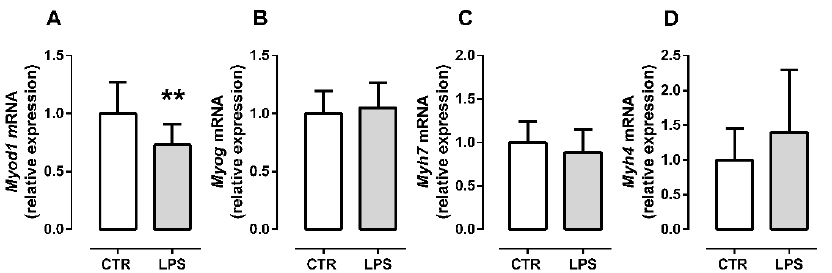
Figure 2. LPS administration affects initial myogenic stimulus but not late differentiation. Myod1 expression at 24 h post differentiation induction ( A ) and expression of Myog ( B ), Myh7 ( C ), and Myh4 ( D ) in C2C12 myocytes/myotubes mixed culture at 96 h post differentiation induction. The white bar represents the control group (CTR), and the gray bar represents the LPS group (LPS, 10 ng/mL). Data are expressed as mean ± SD of 12 independent experiments. The data normal distribution was confirmed by D’Agostino and Pearson omnibus test; the parametric Student’s t -test was applied. ** p <